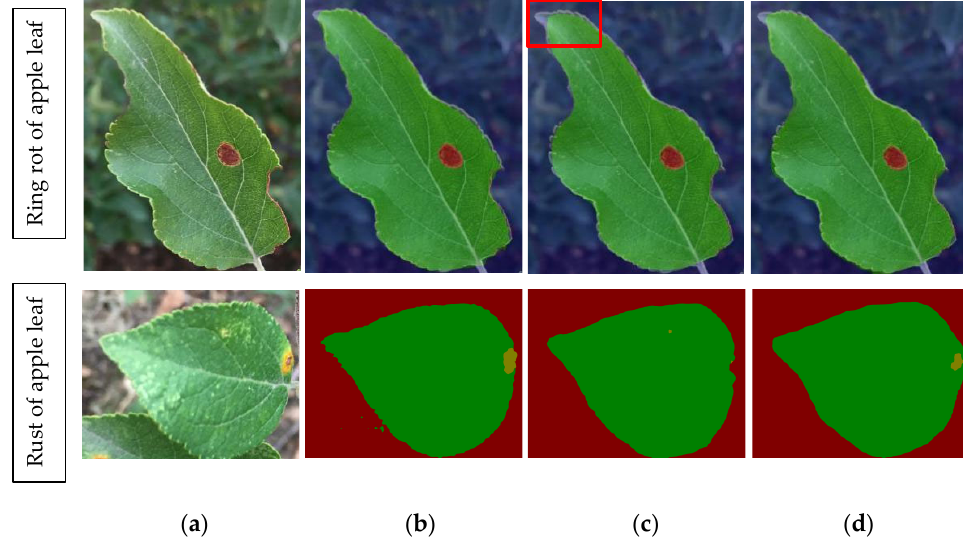
Figure 7. Segmentation effect of different models: ( a ) original image; ( b ) DeepLabV3; ( c ) GCNet; ( d ) PSPNet.